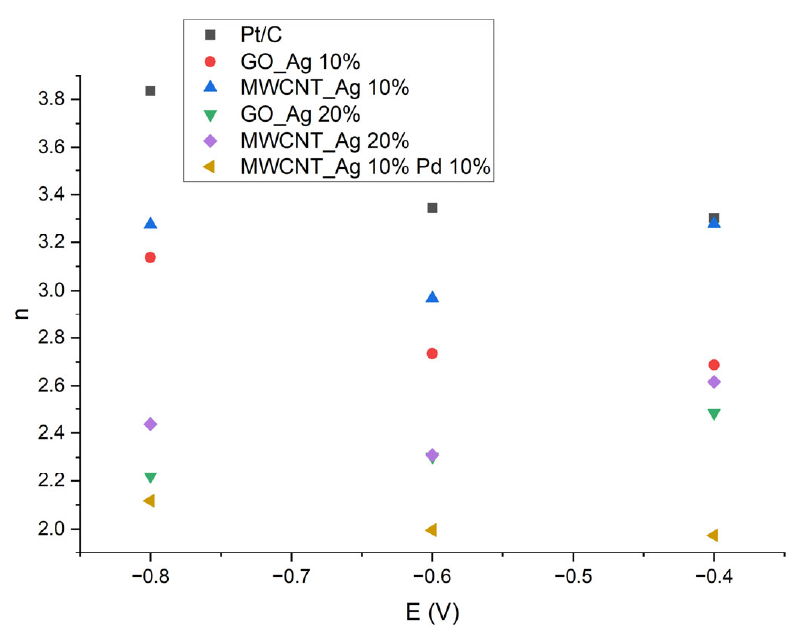
Figure 9. Dependence of the number of electrons transferred in the oxygen reduction reaction on the potential.